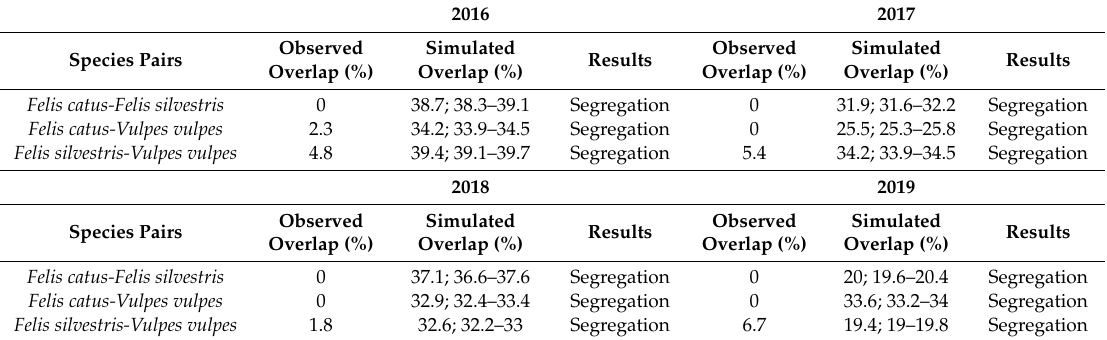
Table 4. Observed and simulated percentages of spatial segregation in 100 m grids between domestic cats, European wildcats and red foxes in pastures. Simulated data (mean and 95% CI are presented) were obtained from 1000